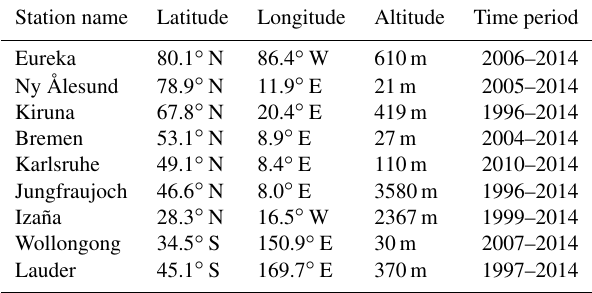
Table 1. List of MUSICA ground stations used for the